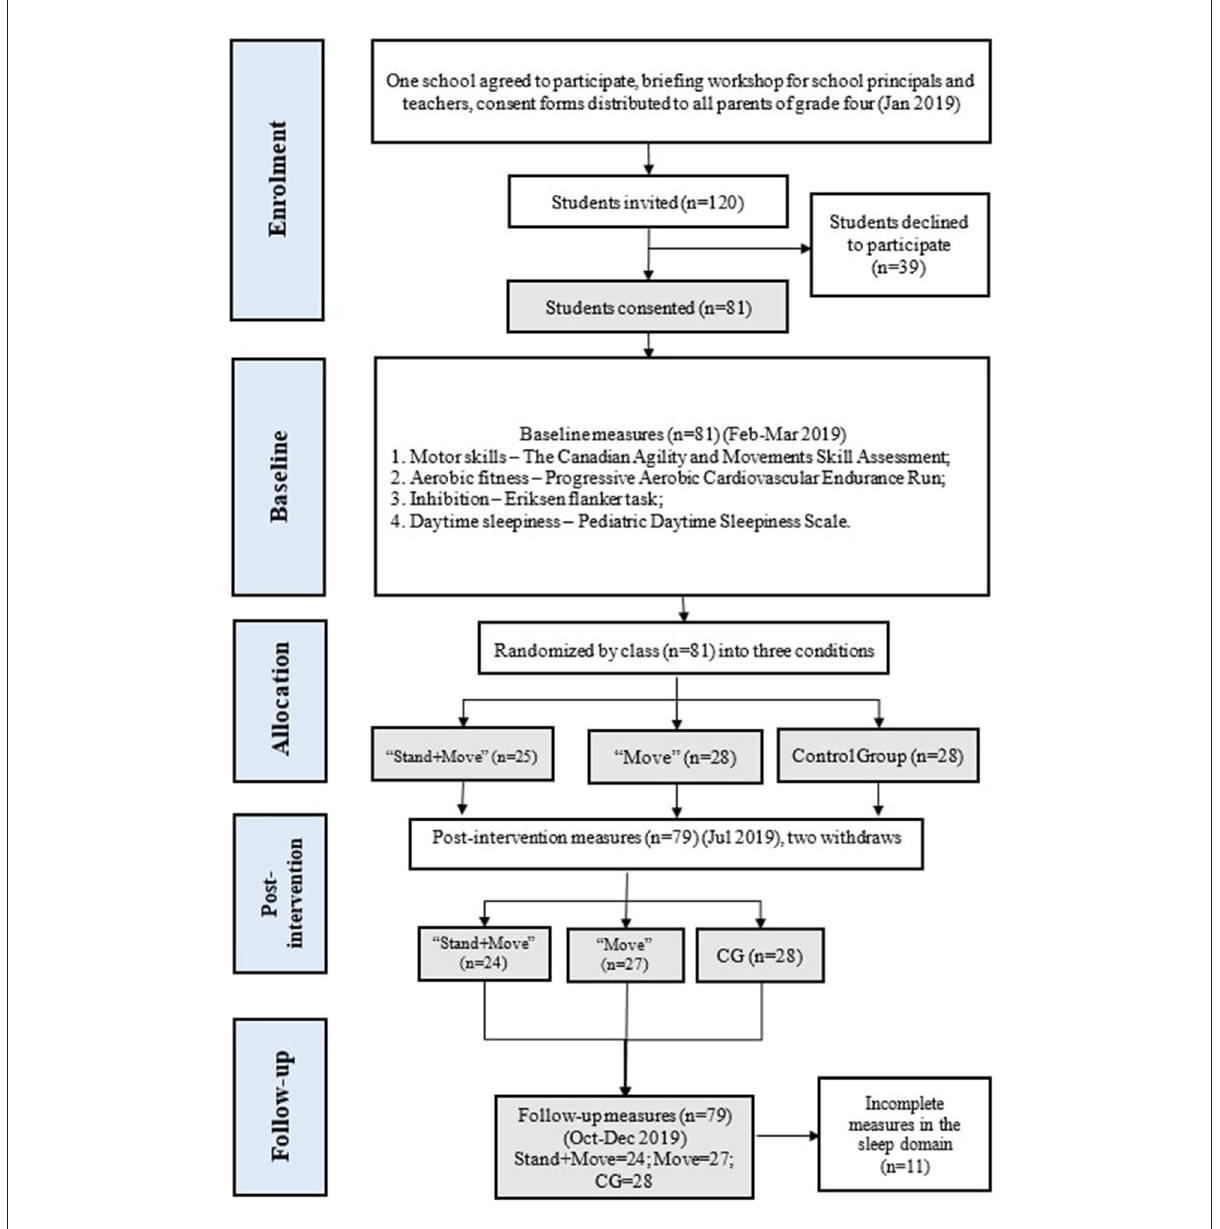
FIGURE1 Flow diagram for the blended classroom